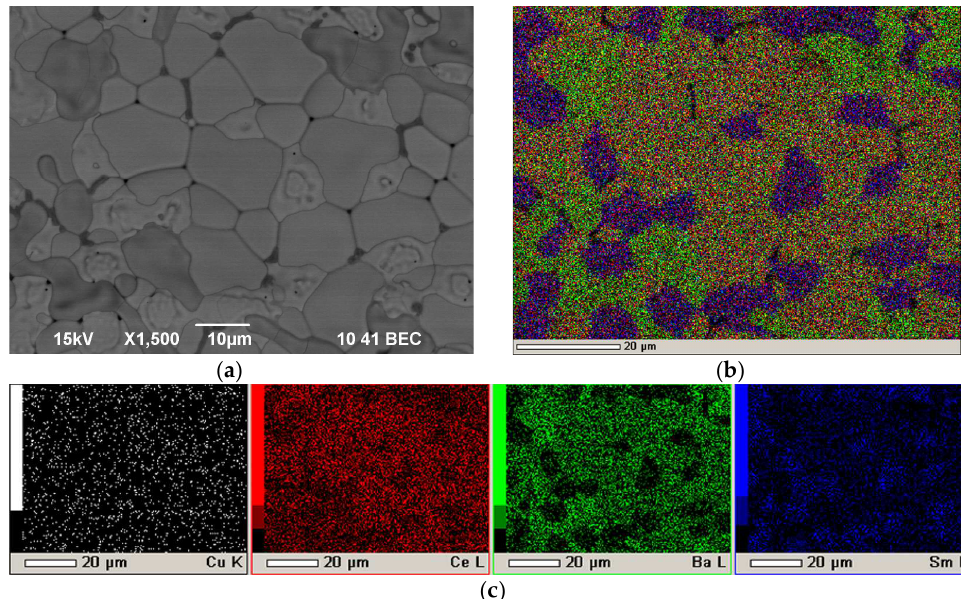
Figure 8. Surface of the BCS-CuO/SDC electrolyte layer after sintering at a temperature of 1450 °С for 5 h on the NiO-BCS-CuO anode substrate (BCS-4 sample): ( a ) SEM image, magnification ×1500; ( b ) integral map of the elements’ distribution; ( c ) individual elements’ maps.